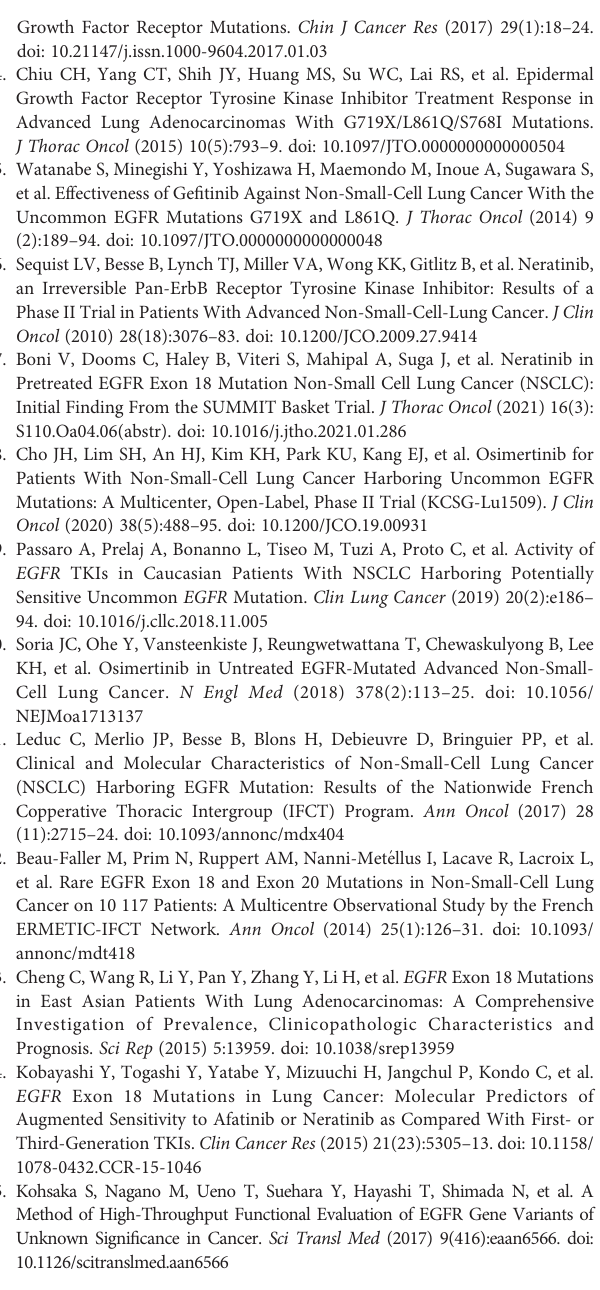
(C) Brain metastases with different treatment modalities. ( EGFR , epidermal growth factor